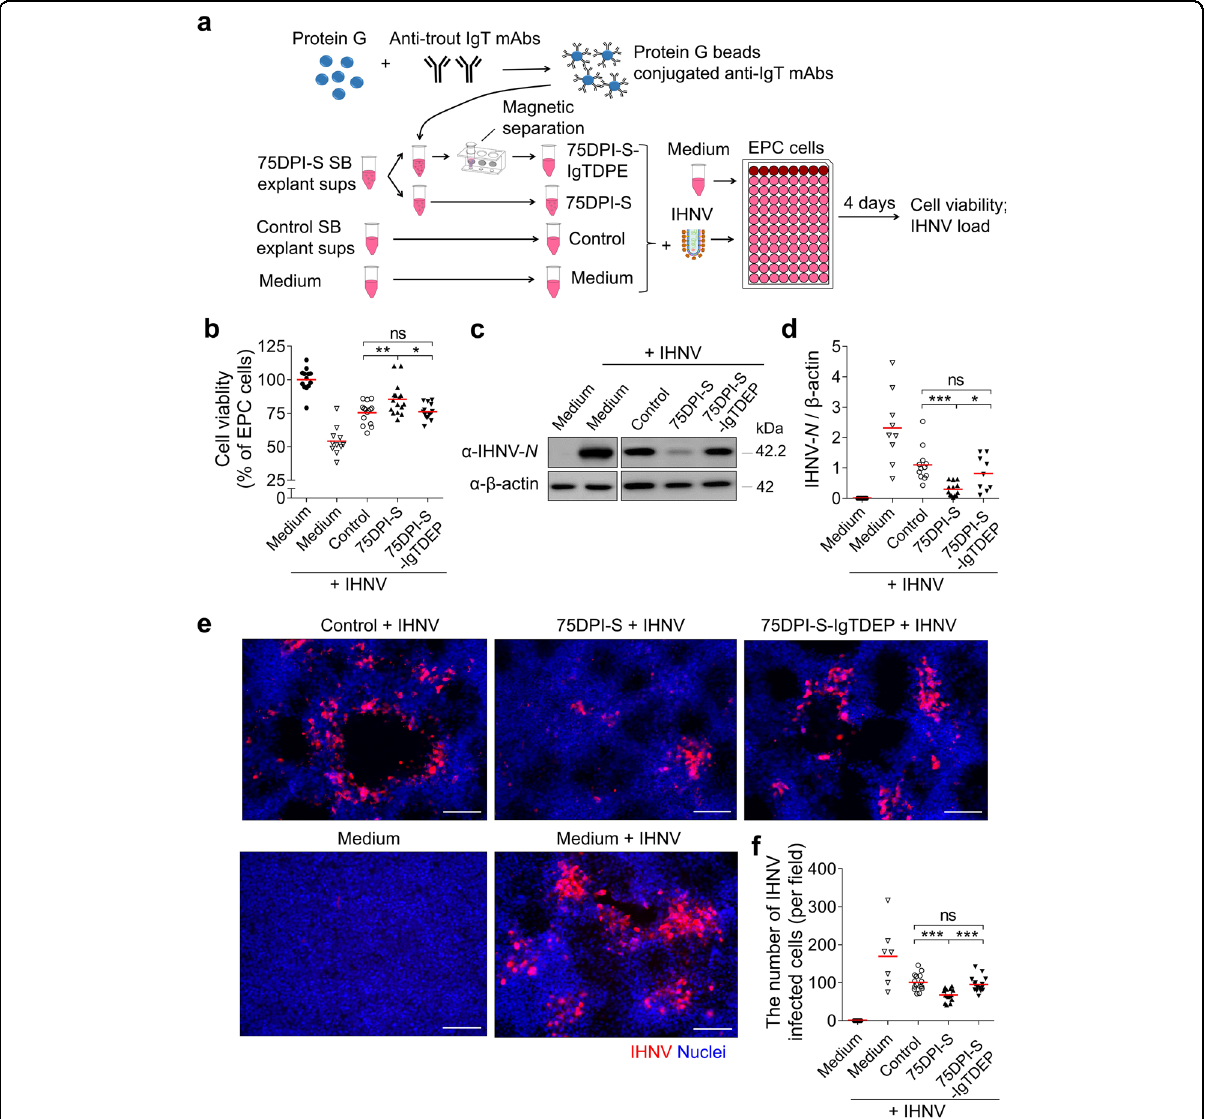
Fig. 6 Viral neutralization exerted by IHNV-speci fi c sIgT from SB of 75DPI-S fi sh. a Scheme of the experimental strategy. Magnetic protein G beads were incubated with anti-trout IgT mAbs to generate protein G beads coated with anti-IgT mAbs. SB explant supernatants (sups) from control and 75DPI-S fi sh were collected after 3 days incubation with MEM medium. IgT from 75DPI-S SB explant sups was depleted by incubating these sups with protein G beads coated with anti-IgT mAbs. Thereafter, IHNV was pre-incubated with medium alone or SB explant sups derived from control, 75DPI-S, or 75DPI-S-IgTDEP fi sh, and each of these IHNV-containing sups were added to EPC cells. Four days after addition of the different SB explant sups or medium alone to EPC cells, these fi ve groups of EPC cell treatments (including: Medium (EPC cells), Medium + IHNV (IHNV-EPC cells), Control (control sups-IHNV-EPC cells), 75DPI-S (75DPI-S sups-IHNV-EPC cells), and 75DPI-S-IgTDPE (75DPI-S-IgTDPE sups-IHNV-EPC cells)) were analyzed for EPC cell viability and presence of IHNV- N protein. b The cell viability in the different groups were measured by the colorimetric alamarBlue assay and presented as relative values to those of EPC cells ( n = 10 – 16). c The IHNV- N protein expression in EPC cells was detected by western blot using an anti-IHNV- N mAb. d Relative expression of IHNV- N protein in EPC cells was evaluated by densitometric analysis of immunoblots and presented as relative values to those of control fi sh ( n = 9 – 13). e The IHNV- N protein in EPC cells was detected by immuno fl uorescence using the anti-IHNV- N mAb (Isotype-matched control antibody staining is shown in Supplementary Fig. S2c). Scale bars, 100 μ m. f Numbers of virally infected cells were calculated from e ( n = 7 – 15). Each symbol ( b , d , f ) represents an individual fi sh; small horizontal red lines ( b , d , f ) indicate the means. Statistical differences were evaluated by one-way ANOVA with Bonferroni correction. Data in b , d , and f are representative of at least three independent experiments (mean± SEM). * P < 0.05, ** P < 0.01, and *** P <